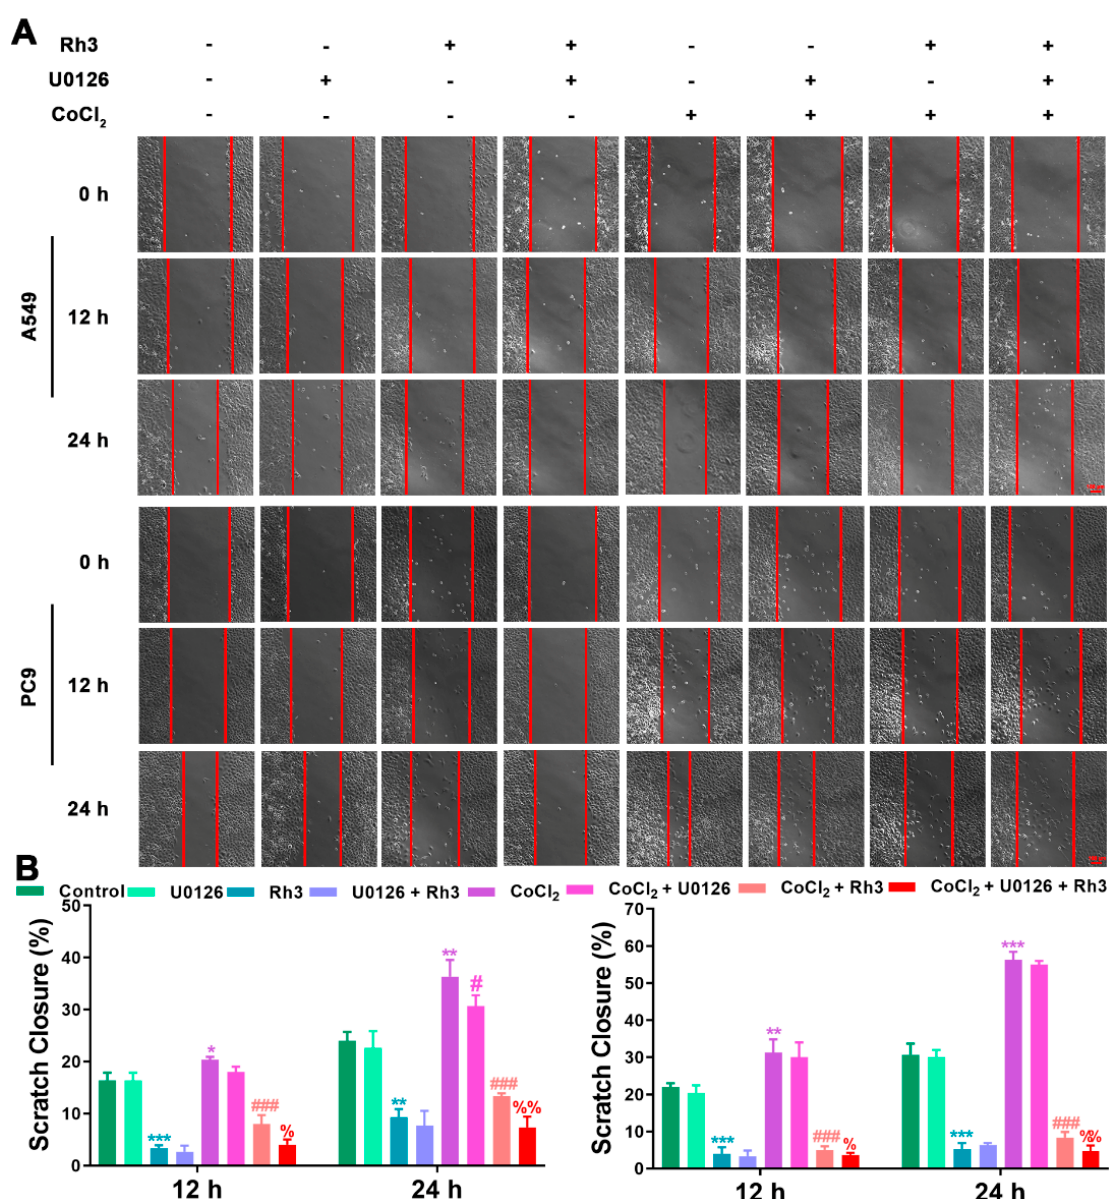
Figure 6. U0126 augments the inhibitory action of Rh3 in A549 and PC9 cells with respect to metastatic ability. ( A ) A549 and PC9 cells treated with 40 µ M Rh3, 10 µ M U0126, and 100 µ M CoCl 2 for the wound-healing assay. ( B ) The wound closures for A549 and PC9 cells at 12 h and 24 h are represented using the histogram. * p < 0.05, ** p < 0.01, *** p < 0.001 compared with the control group; # p < 0.05, ### p < 0.001 compared with the CoCl 2 group; % p < 0.05, %% p < 0.01 compared with the CoCl 2 + Rh3 group.